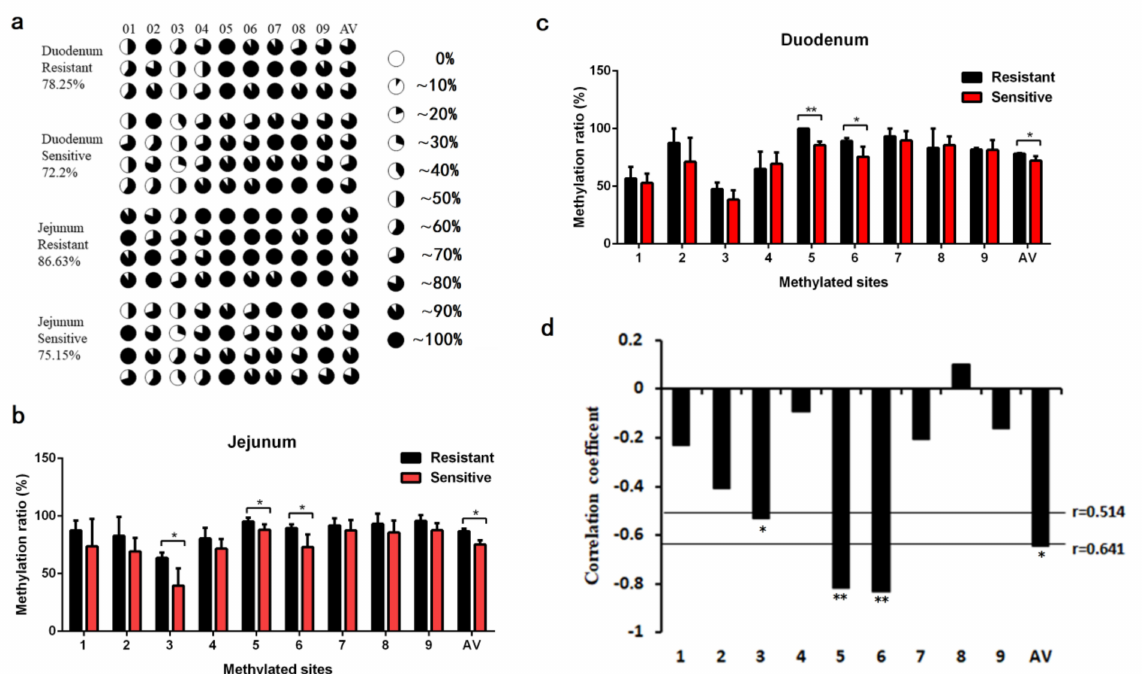
Figure 5. Effect of pig FUT3 promoter methylation level on gene expression. ( a ) The methylation level of the identified CpG sites. 1~9 mean the different CpG sites, accordingly. CpG sites are observed with pie charts in which the black region shows the level of methylation. AV: the average degree of methylation. ( b ) Differential methylation analysis in jejunum tissues from E. coli F18-sensitive and -resistant individuals. ( c ) Differential methylation analysis in duodenum tissues from E. coli F18-sensitive and -resistant individuals. Results are indicated as mean ± SEM, * p < 0.05, ** p < 0.01. ( d ) Correlation analysis between the FUT3 methylation and mRNA expression